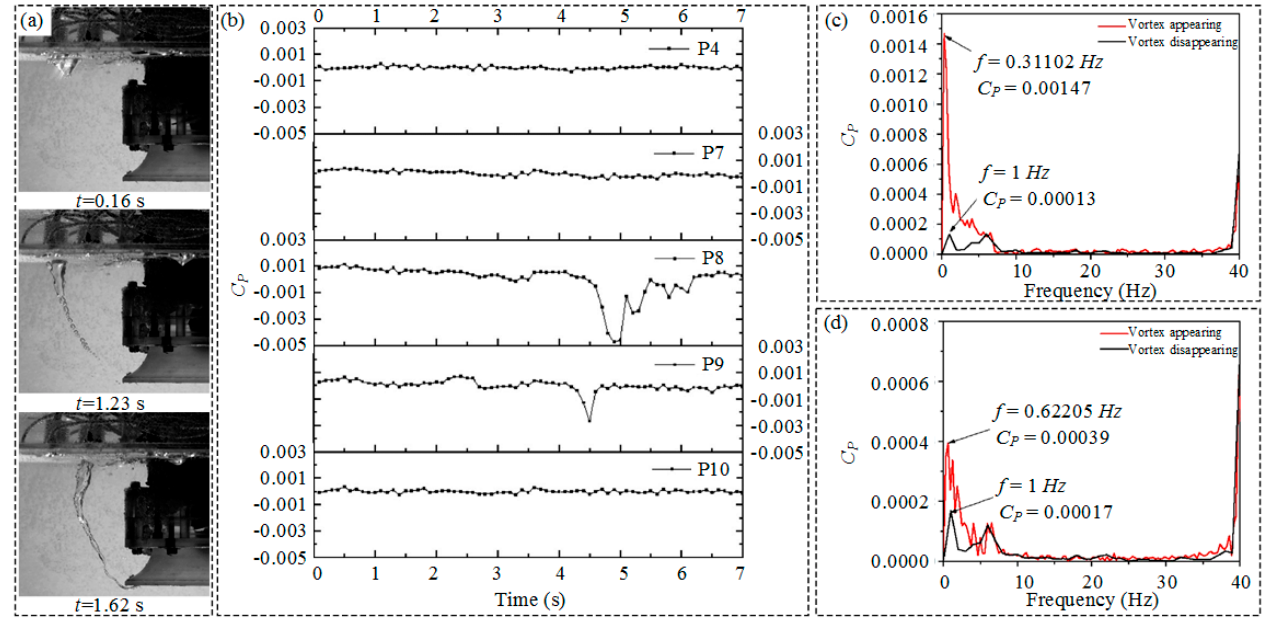
Figure 11. Pressure pulsation evolution of air entrainment. ( a ) Air entrainment process; ( b ) Time domain of monitoring points; ( c , d ) Spectrograms of vortexes and no vortexes. (Reprinted with permission from Ref. [89]. 2020, Elsevier).